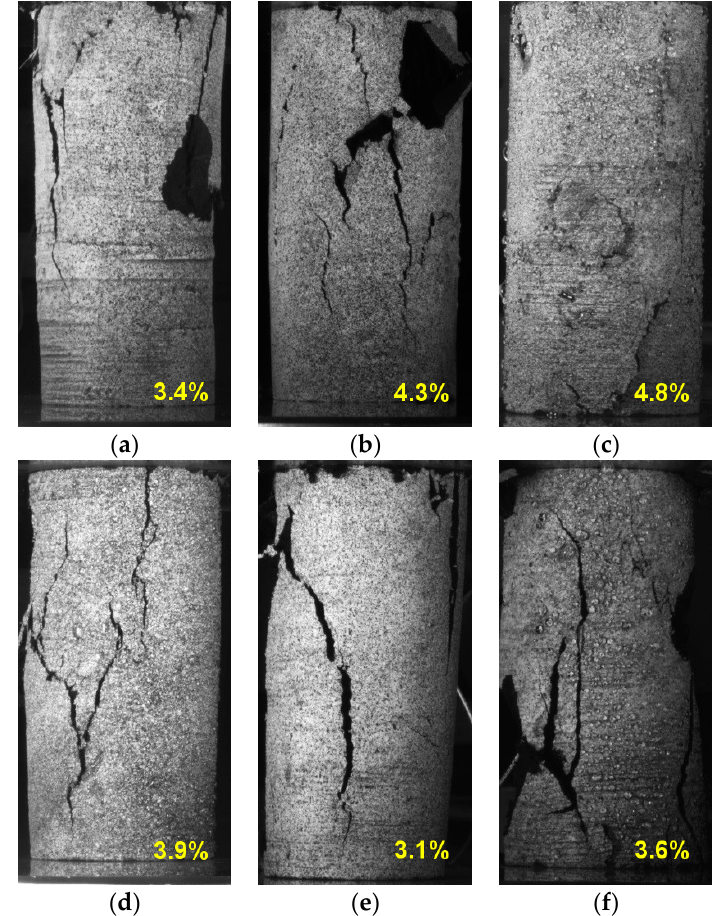
Figure 6. Sample appearance at failure of tested samples (( a ) low moisture, ( b ) unsaturated, ( c ) water saturated, ( d ) 5% brine saturated, ( e ) 15% brine saturated and ( f ) 25% brine saturated. Yellow figures denote the respective maximum strains at failure for each condition).